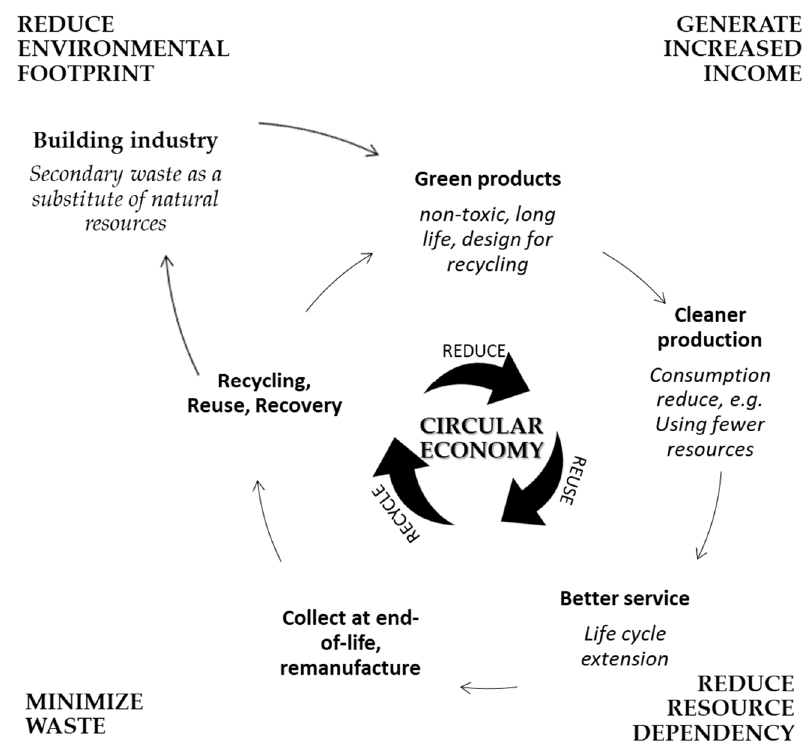
Figure 2. Secondary waste in the circular economy.